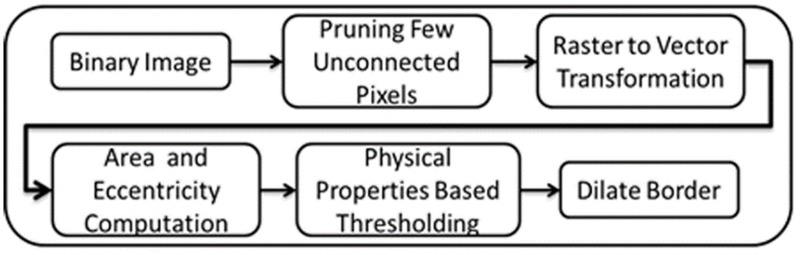
Steps for extraction of VLM.